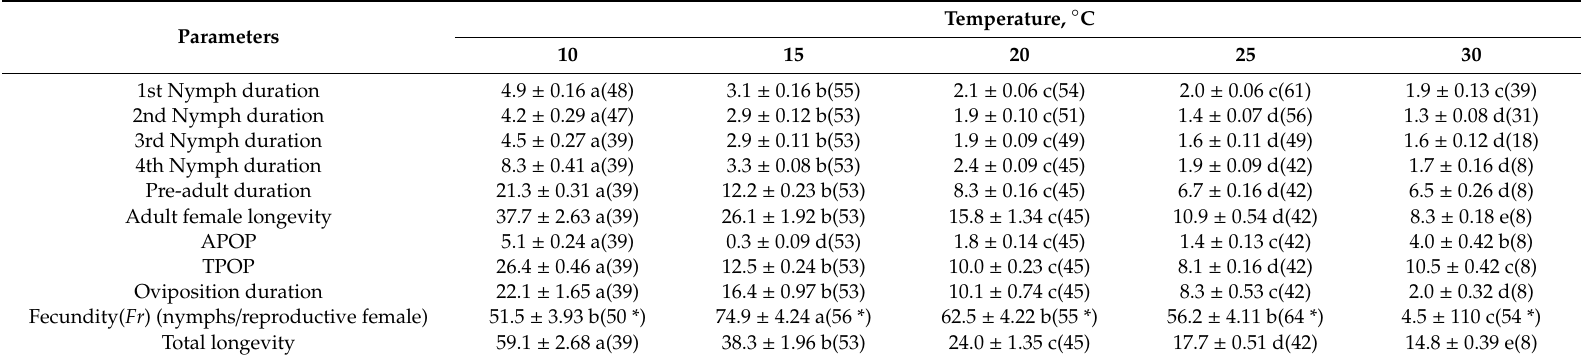
Means in the same row followed by di ff erent letters are significantly di ff erent ( p < 0.05), as determined by the paired bootstrap test. Numbers in parentheses indicate the number of survivors of A. pisum per life stage at each temperature. * in the fecundity row means the number of the initial sample size at each temperature. Table 2. Population parameters and proportions of Acyrthosiphon pisum reproductive adult females and N-type individuals (those that died in pre-adult stages) at five di ff erent temperatures.